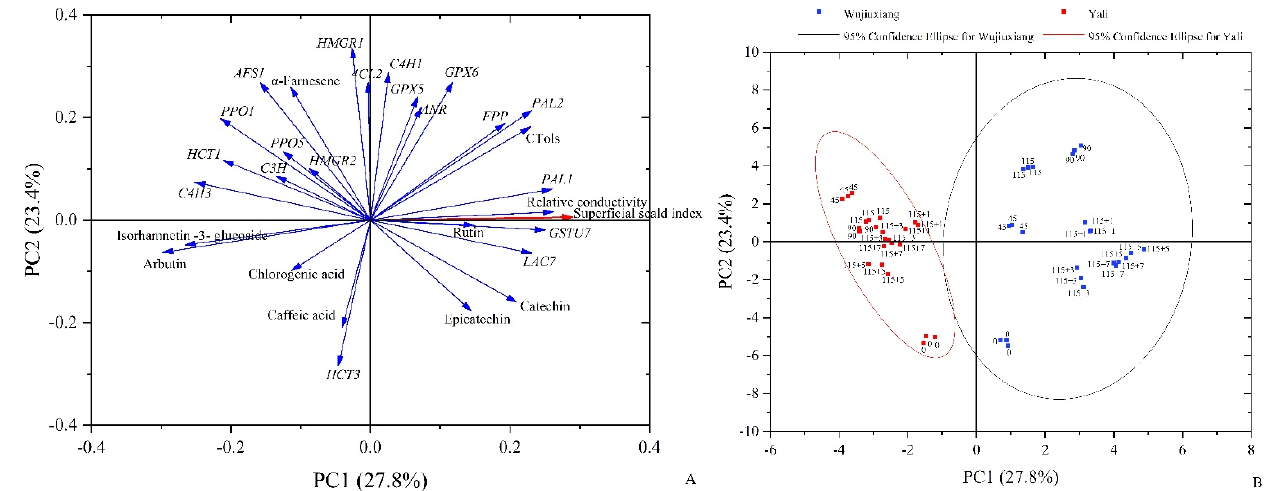
Figure 7. Loading plot ( A ) and score plot ( B ) of the principal component analysis (PCA) of the scald index, α -farnesene, CTols, and phenolic contents, as well as the related gene expression levels in ‘Yali’ and ‘Wujiuxiang’ pears. Note: arrows indicate the different variables. In the score plot, 0, 45, 90, 115, indicate the duration time of cold storage at 0 °C, 115 + 1, 115 + 3, 115 + 5, and 115 + 7, indicating 1, 3, 5, and 7 days of shelf life at room temperature (20 °C) after cold storage at 0 °C for 115 days.